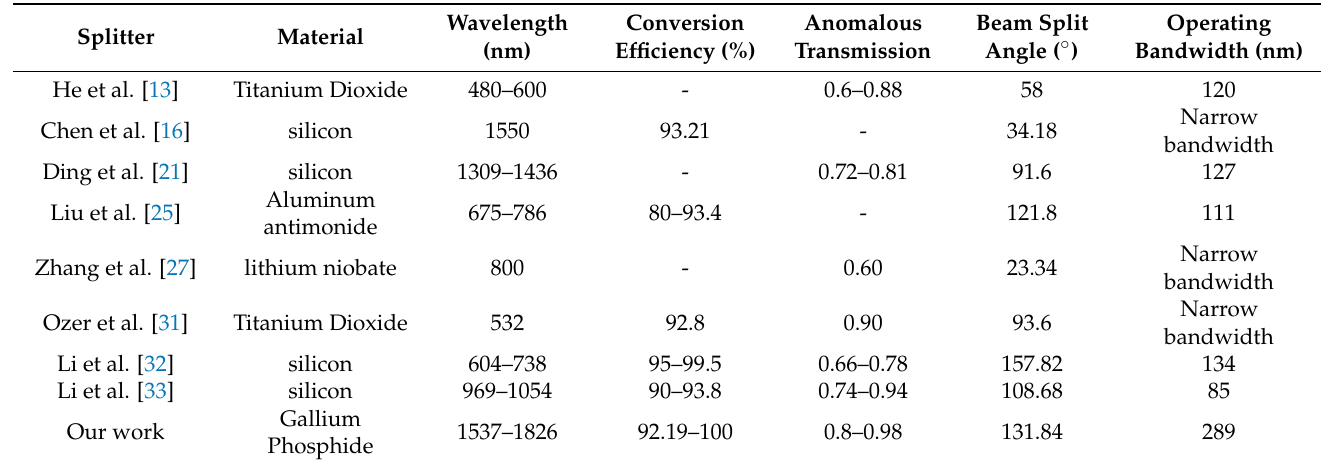
Table 1. Performances of the proposed structure and the previous reports based on discrete and quasi-continuous metasurfaces.